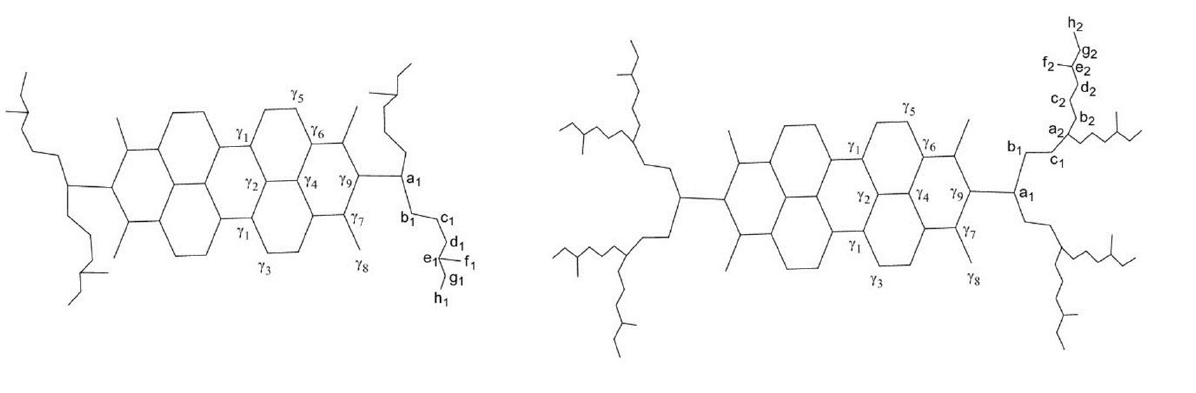
Figure 2: From left to right, D